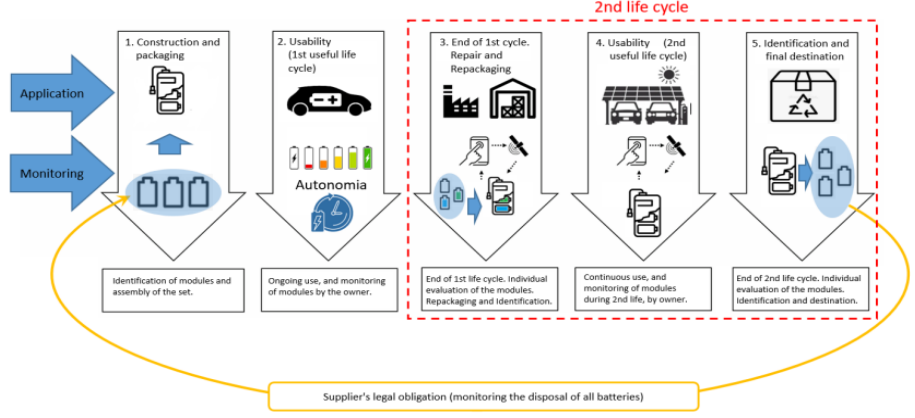
Figure 1. Block diagrams of phases of the battery (applications and monitoring).